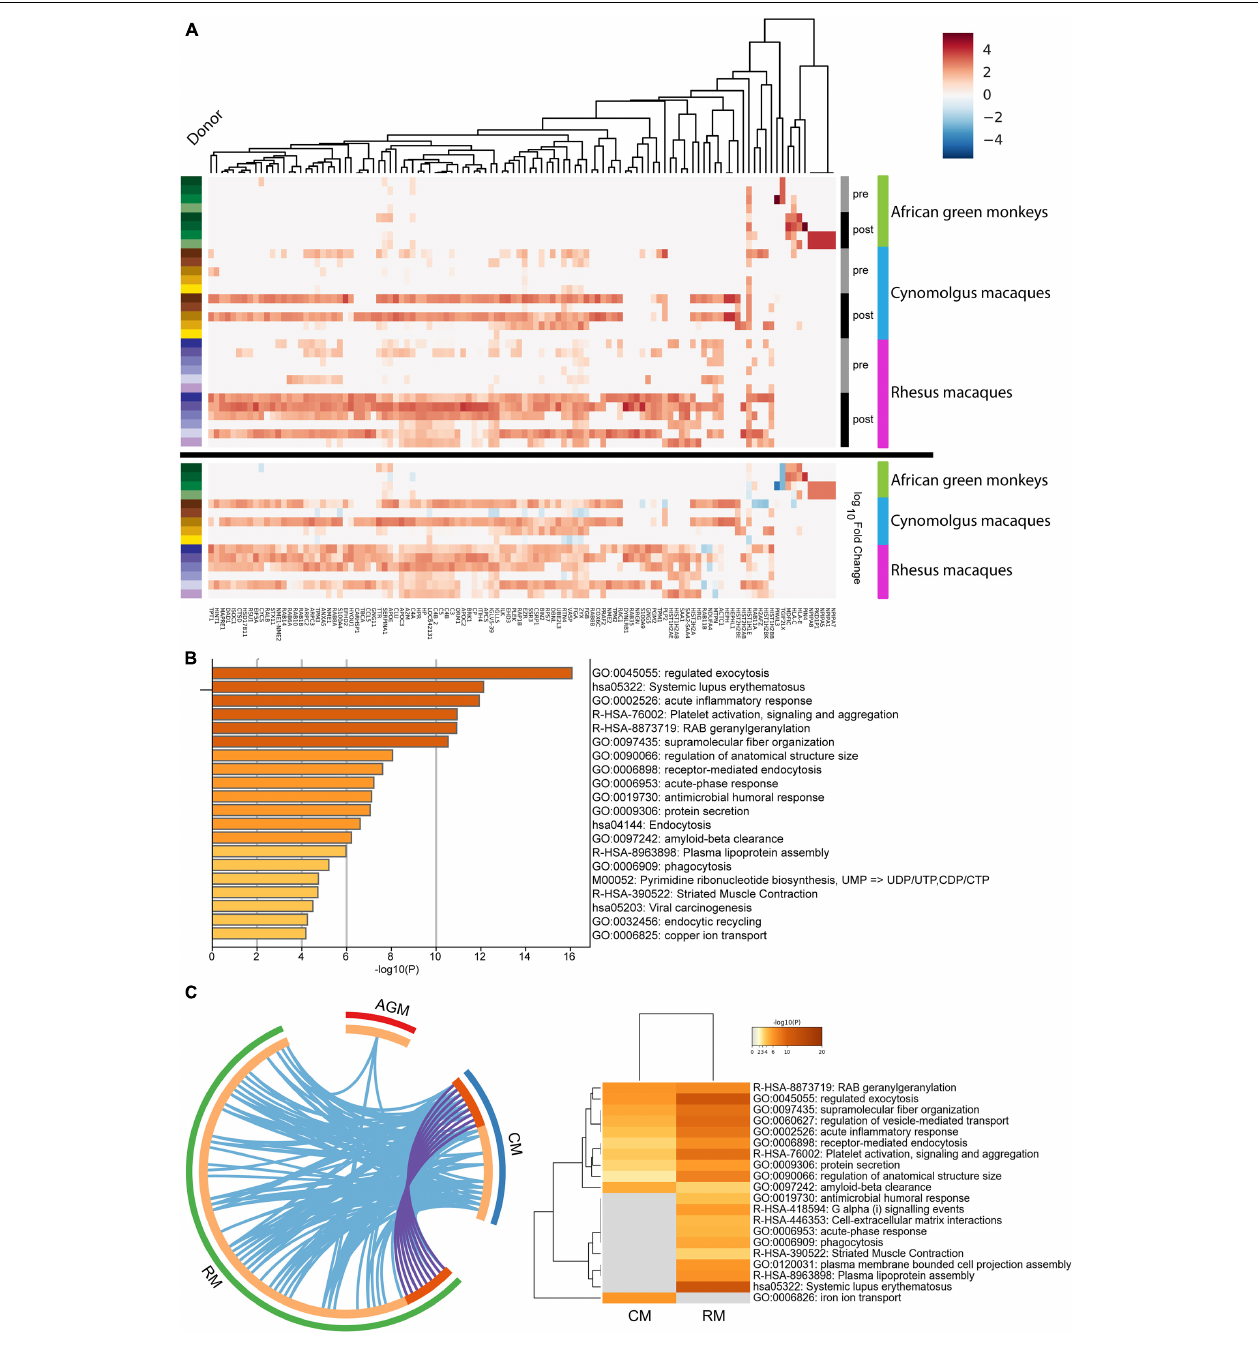
FIGURE 2 | Hierarchical clustering of 115 proteins whose expressions were altered in B. mallei infected rhesus macaques, African green monkeys and cynomolgus macaques. (A) The expression pattern of 115 proteins was hierarchical clustered. A continuum of blue (low expression) to red (high expression) depicts expression levels of the protein. The heat maps under the “Log 10 Fold Change” bar depict the expression fold changes of proteins in logarithmic scale by normalizing B. mallei infected to uninfected samples. The heatmap under the “Pre” and “Post” bars represent expressions of PBMC derived proteins collected before and after B. mallei infection, respectively. Samples derived from individual donors were color coded (left panel). (B) Statistically significant overrepresentation of functional classes and protein families were presented. (C) The inner circle represents protein lists, where hits are arranged along the arc. Proteins that hit multiple lists are colored in dark orange, and proteins unique to a list are shown in light orange. Overlap of upregulated proteins between rhesus (RM) and cynomolgus macaques (CM) is represented as purple lines. Overlap of GO terms between rhesus macaques, African green monkeys (AGM) and cynomolgus macaques is represented as blue lines. All statistically enriched GO terms were first identified, accumulative hypergeometric p -values and enrichment factors were calculated and used for filtering. Remaining significant terms were then hierarchically clustered into a tree based on Kappa-statistical similarities among their gene memberships. 0.3 kappa score was applied as the threshold to cast the tree into term